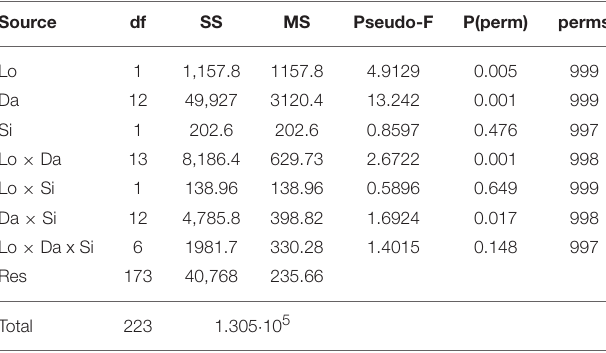
TABLE 1 | Multiple analyses of variance (PERMANOVA) of the gelatinous zooplankton community comparing the Almería and Málaga aquaculture facilities (location), sampling sites (cage, external point), and sampling dates (date).